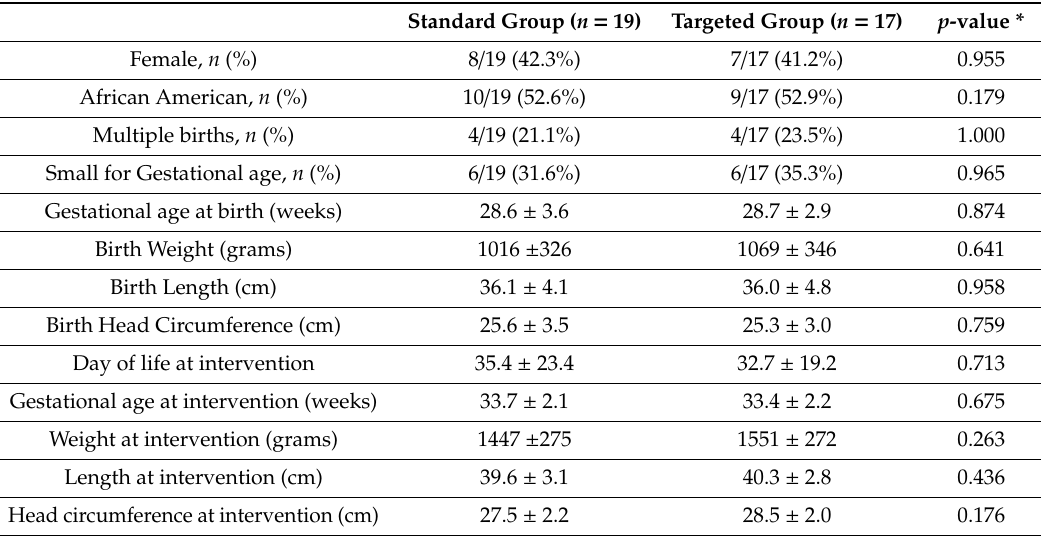
Table 1. Characteristics of infants ( n = 36) according to the feeding regimen (targeted compared with standard fortification groups) 1 .